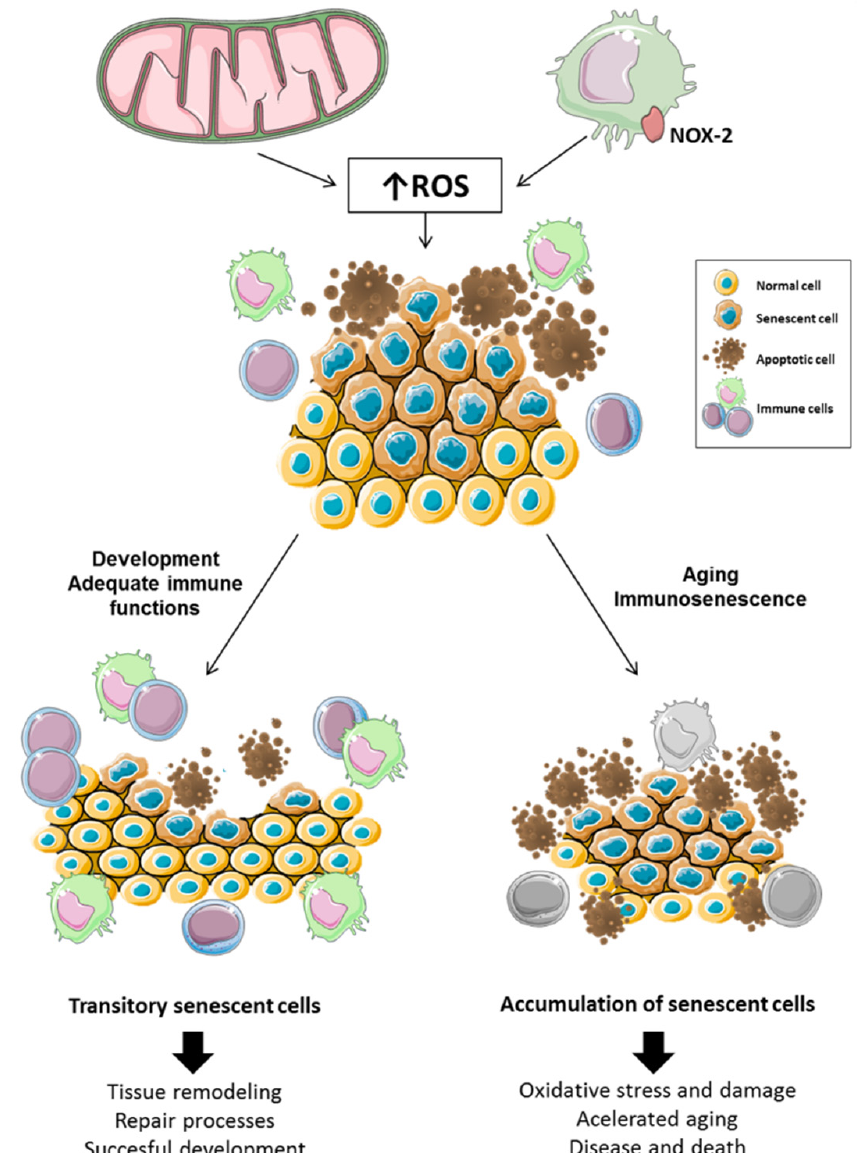
Figure 1. Influence of immunosenescence in the accumulation of senescent cells. Oxidative com- pounds come mainly from two sources, the mitochondria and NOX-2, located in the membrane of immune cells, especially in phagocytes. These oxidative compounds lead to senescent and apoptotic cells. However, senescence can be transient and homeostatic or chronic and damaging depending on the efficiency of immune cells in removing them. Thus, from the fetal stage to adulthood, the senescent cells that appear are transitory thanks to the adequate function of immune cells. Thus, immune cells remove these cells, promoting regeneration and repair processes, which are crucial for proper development. However, from adulthood to death, chronic exposure to ROS produces oxida- tive tissue damage and deterioration of the function of immune cells (immunosenescence), which causes accumulation of senescent and apoptotic cells, leading to accelerated aging and, consequently, increased morbidity and